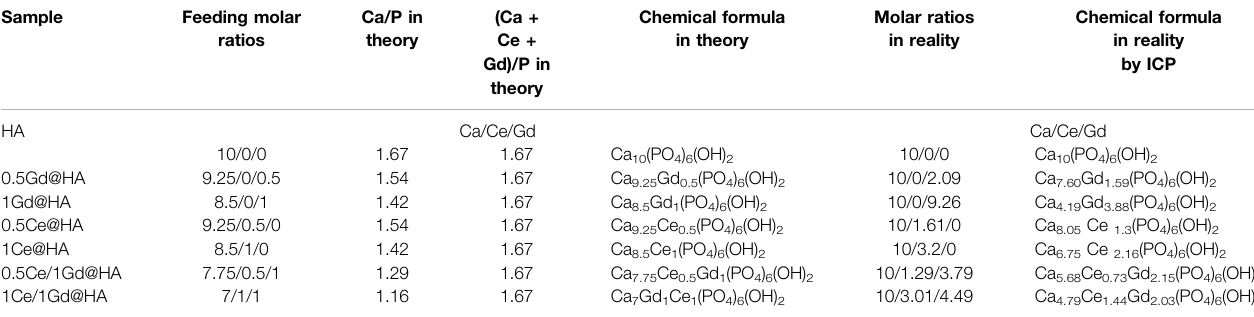
TABLE 2 | Chemical component analysis of Ca, Ce, and Gd in Ce/Gd@HA and HA NPs. Sample Feeding molar